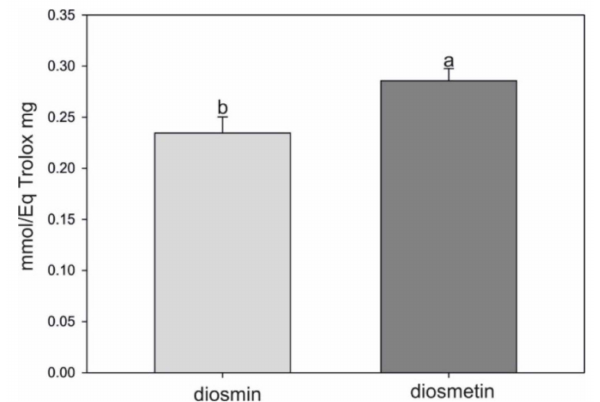
Figure 5. Antioxidant capacity of diosmin and diosmetin measured using the DPPH method and expressed as mM of diosmin or diosmetin per mg of Trolox. The data are means ± SD ( n = 3). The lowercase a and b denote significant differences between objects according to Student’s test ( p ≤